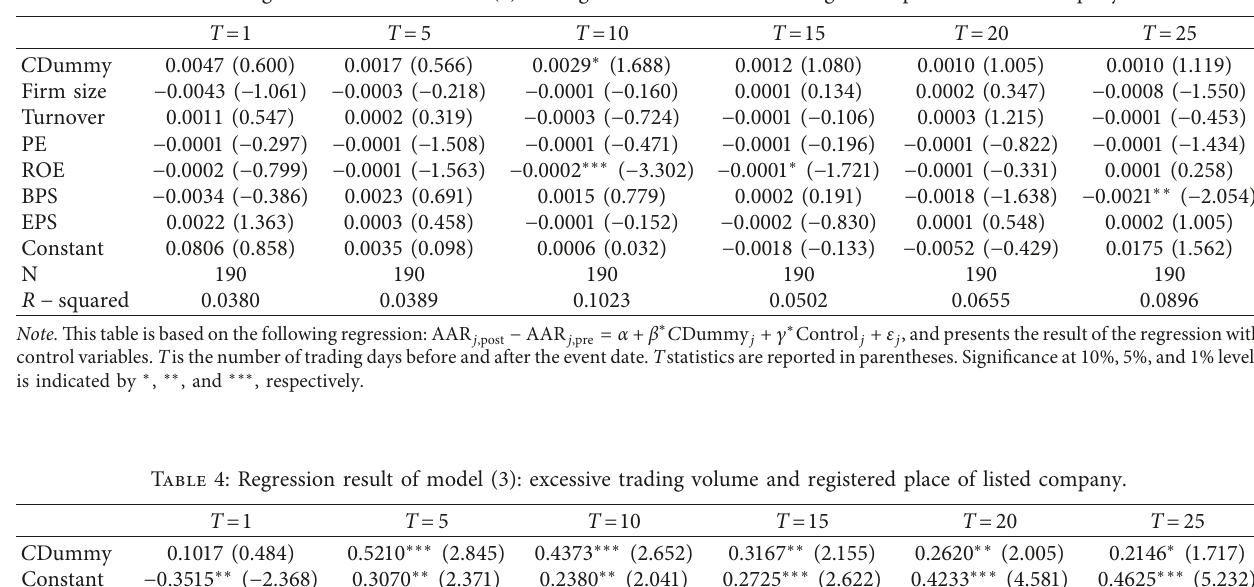
Table 3: Regression result of model (2): average abnormal return and registered place of listed company.